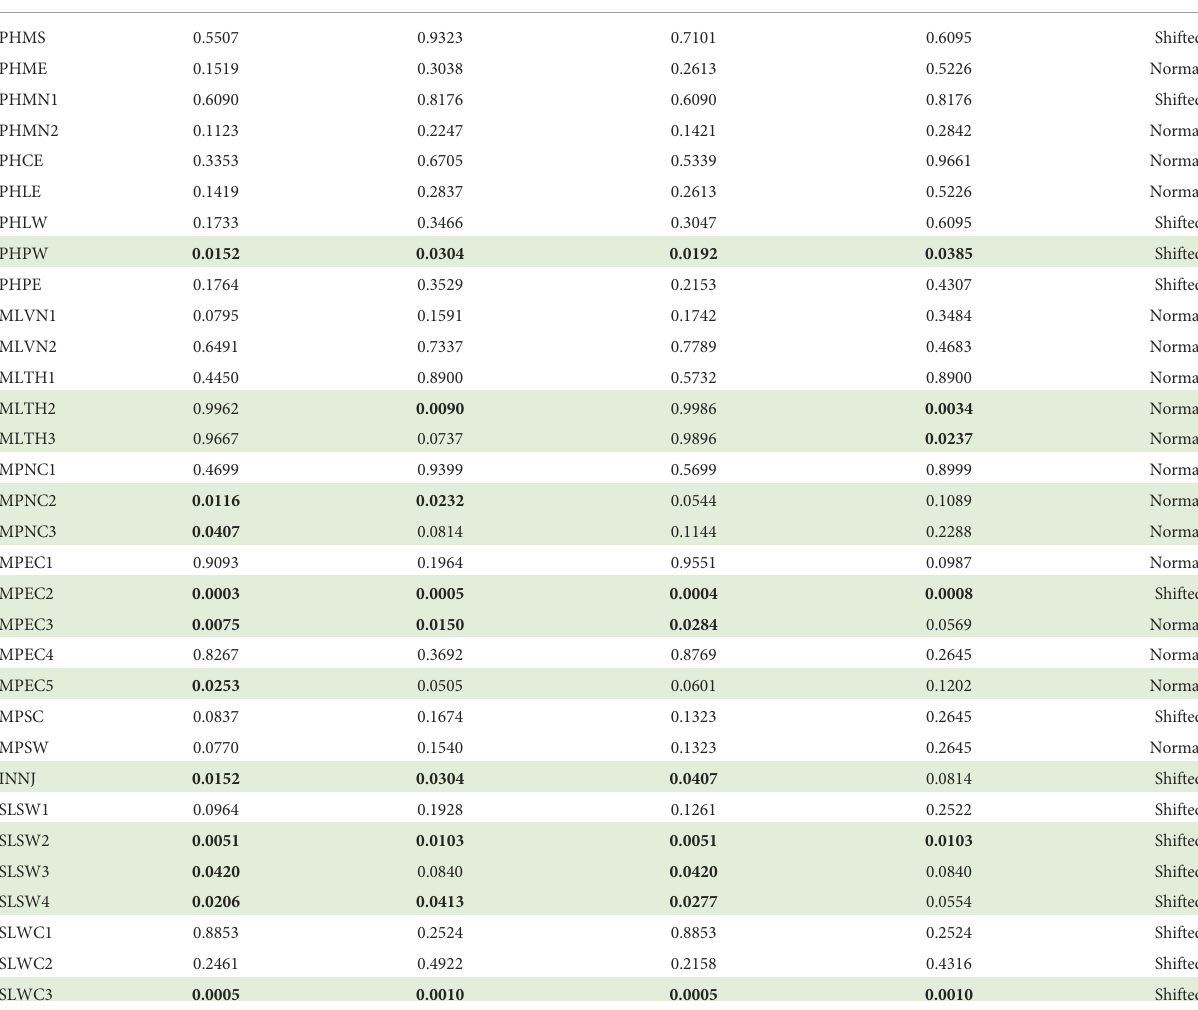
TABLE 5 All the p-value of Wilcoxon ’ s tests for bottleneck of nipa populations in the Indo-West Paci fi c across 18 microsatellite loci z .